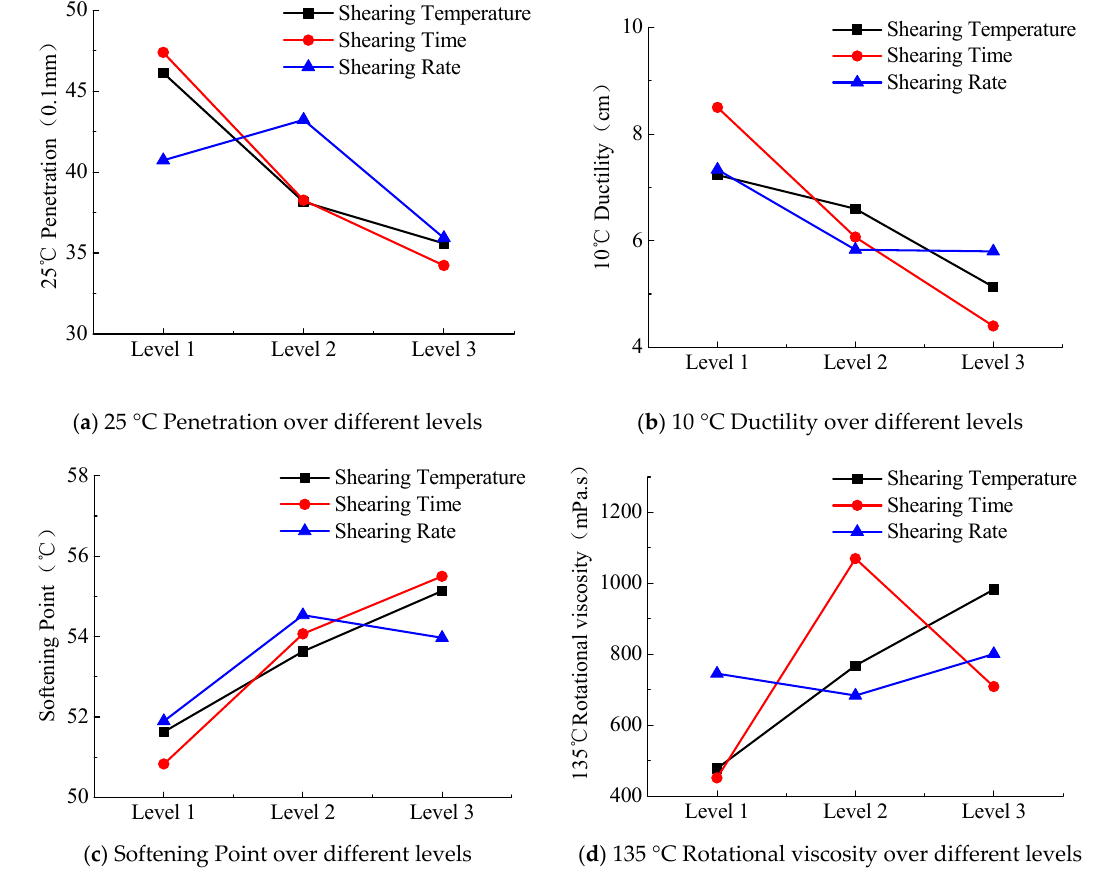
Figure 2. Average Value Change of Five Indicators over Influence Factors and their Levels.